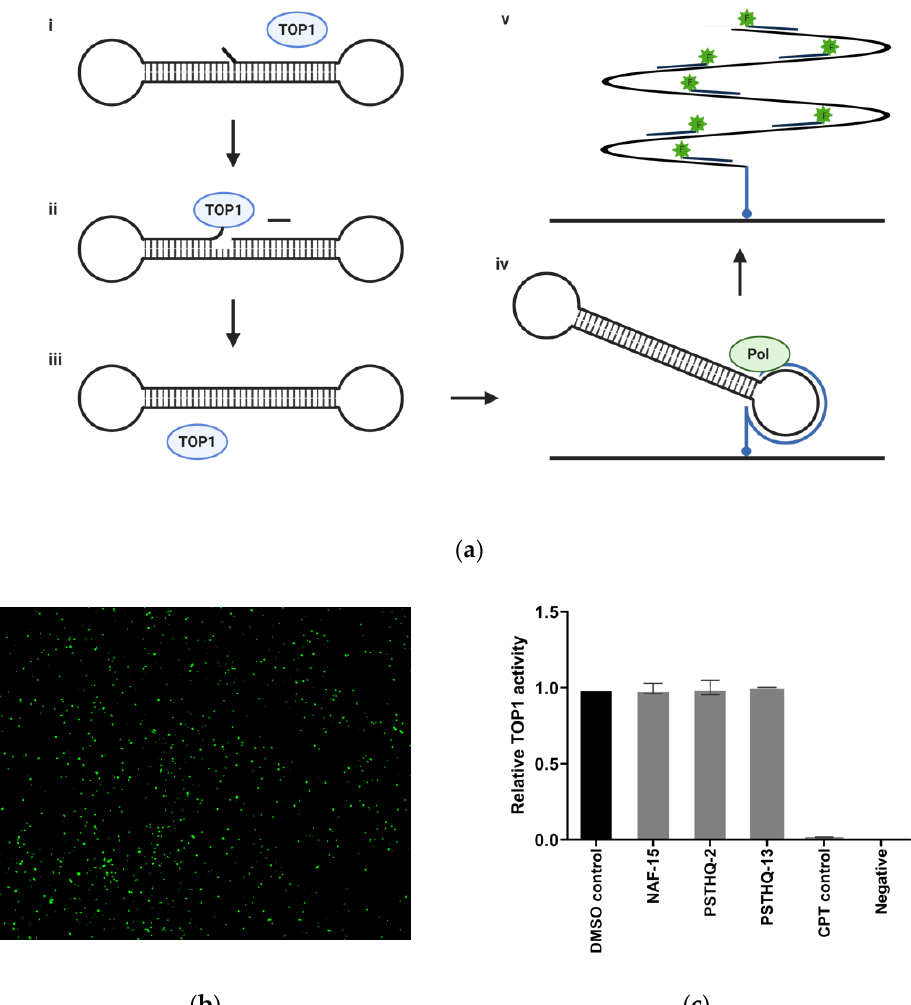
Figure 3. TOP1 activity after treatment with molecular compounds. ( a ) Illustration of the TOP1 activity assay named Rolling-circle Enhanced Enzyme Activity Detection (REEAD). The TOP1 sensor is a dumbbell DNA substrate with an AGA 5′overhang (i). TOP1 cleaves the AGA overhang (ii) and ligates the remaining nick, thereby releasing the TOP1 protein capable of participating in a new cycle and leaving a closed dumbbell substrate (iii). The primer for rolling circle amplification (RCA) is coupled to a microscopic slide, and the dumbbell substrate is hybridized to the RCA primer. Phi29 polymerase (Pol) initiates RCA from the RCA-primer, using the closed dumbbell substrate as template (iv). Fluorophore (F) coupled oligoes complementary to the RCA product hybridize to the synthesized strand, making visualization of the RCA-product possible in a fluorescence microscope (v). ( b ) Representative pictures of circles on a microscopic slide where each green dot represents a signal from one dumbbell substrate and thereby one TOP1 cleavage-ligation reaction. Amount of green signals is a measure of TOP1 activity represented as a column graph in c. ( c ) TOP1 activity after treating purified TOP1 enzyme with the three TDP1 inhibitors or CPT. All samples with TDP1 inhibitors and CPT had a final concentration of 80 µM. DMSO control contained 1.6% DMSO, which is the same DMSO amount as in the samples with potential TDP1 inhibitors and CPT. CPT control is a positive control for TOP1 inhibition. All data were normalized to the DMSO control.